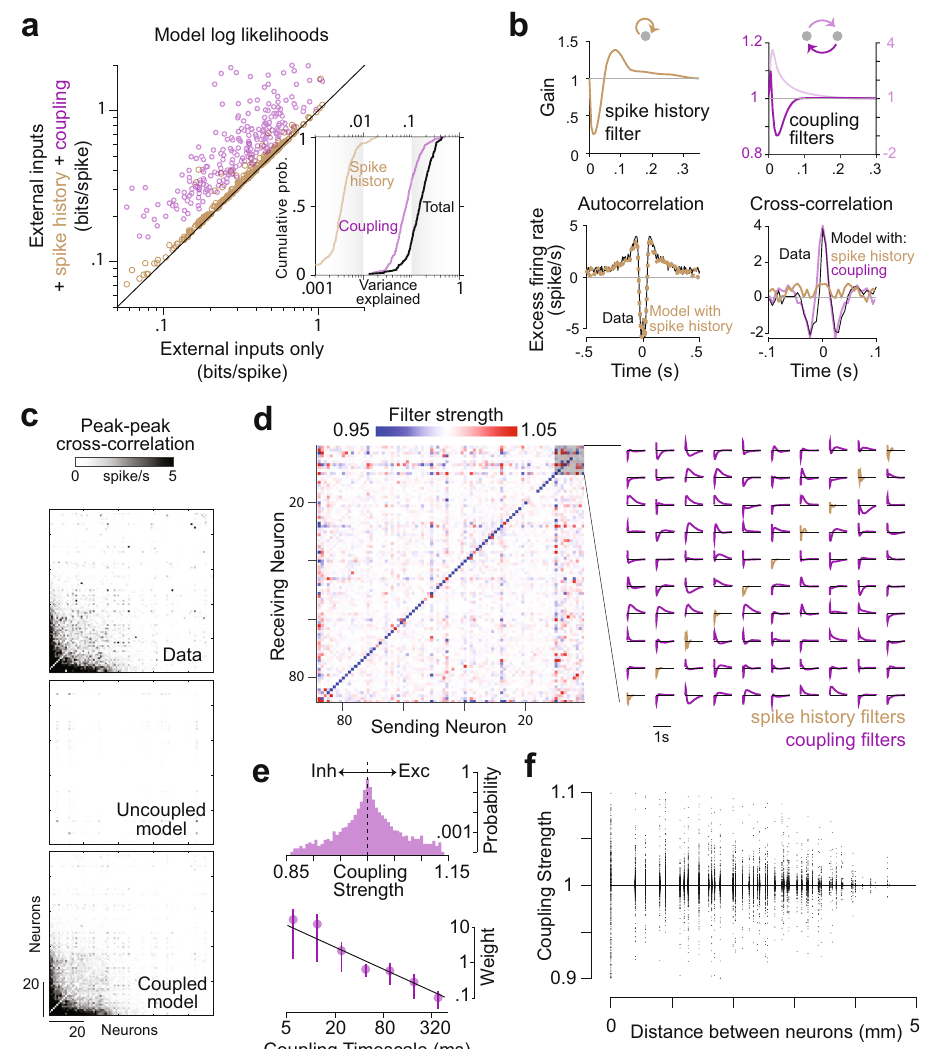
Fig. 4 | Coupling encapsulates population structure. a Comparison of the log likelihoods of the model constructed using only external inputs as predictors againstthoseofamodelthatalsoincludedeffectsofspike-history(brown),against a model with both spike-history and inter-neuronal coupling (maroon). Each circle denotes an individual neuron. Inset shows the cumulative distribution of the con- tribution of spike historyand neuron-neuron coupling,calculatedasthe reduction in variance explained by the model after removing those fi lters. Black curve shows thedistributionofthevarianceexplainedbythefullmodel. b Topleft:Spikehistory fi lter of an example neuron. Bottom left: Model with spike history fi lter accurately captures the autocorrelation function of the neuron. Top right: Bidirectional cou- pling fi lters between an example pair of neurons. Bottom right: Coupling fi lters capture the cross-correlation between the pair, whereas spike-history fi lters alone do not. c Top: Structure of the peak-to-trough amplitude of cross-correlation between the activity of all pairs of simultaneously recorded neurons from an example monkey. Neurons are ordered according to the weight of their contribu- tion to the fi rst principal component of the population activity. Coupled model (bottom), but not the uncoupled model (middle), captures the structure of cross- correlation of the full population. d Left: The strength of the coupling fi lters